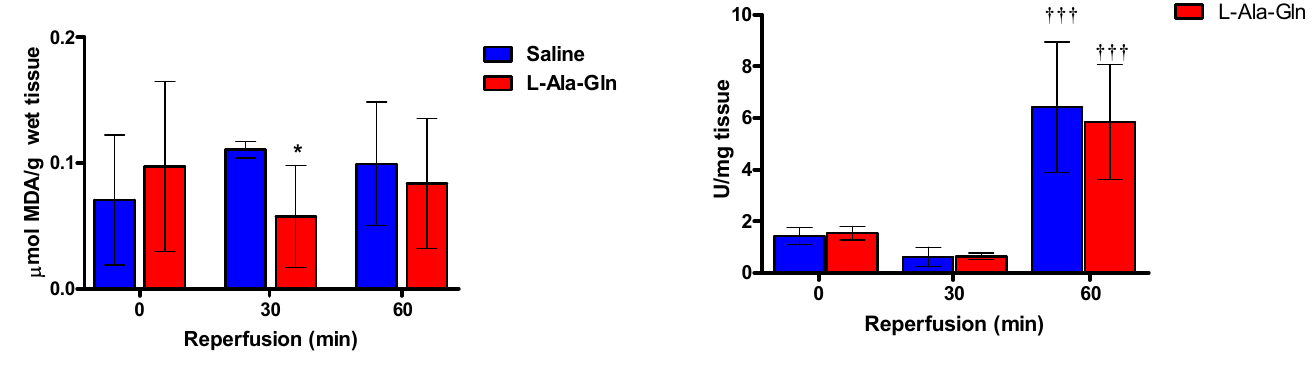
FIGURE 1 - Thiobarbituric acid-reactive substances levels (micromoles of Malondialdehyde per gram of fresh tissue) in cerebral tissue of saline and Ala-Gln pretreated gerbils. Bars represent means±SD of control (blue bars) and L-Ala-Gln (red bars) groups at the end of the ischemia (0 min) and during reperfusion (30 and 60 minutes). L-Ala-Gln group is significantly different from control group (p<0.05) at 30 minutes, by Kruskal-Wallis/Dunn test.